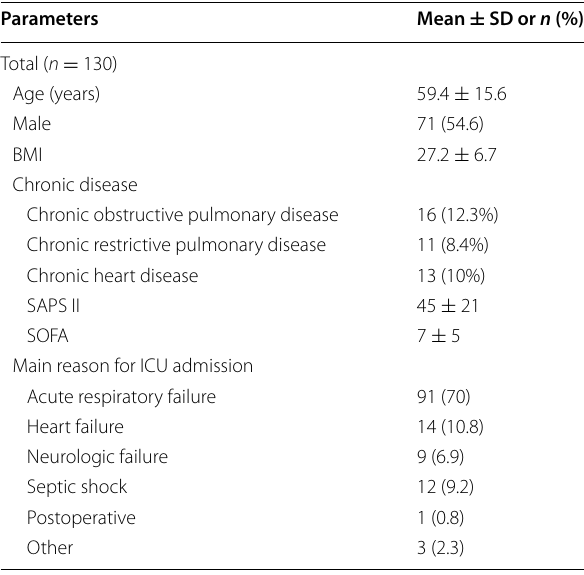
Table 1 Characteristics of the patients at ICU admission